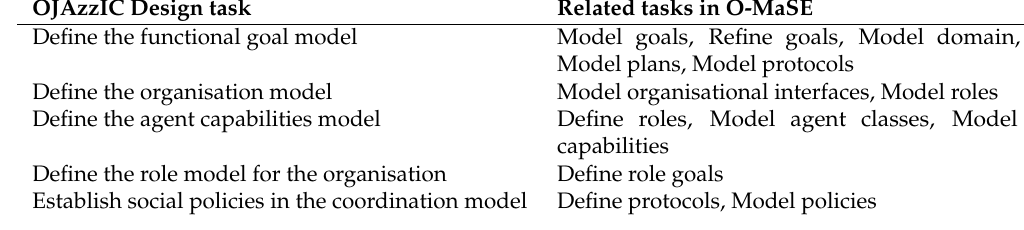
Figure 3. Design tasks in OJAzzIC, and their relationship to the O-MaSE